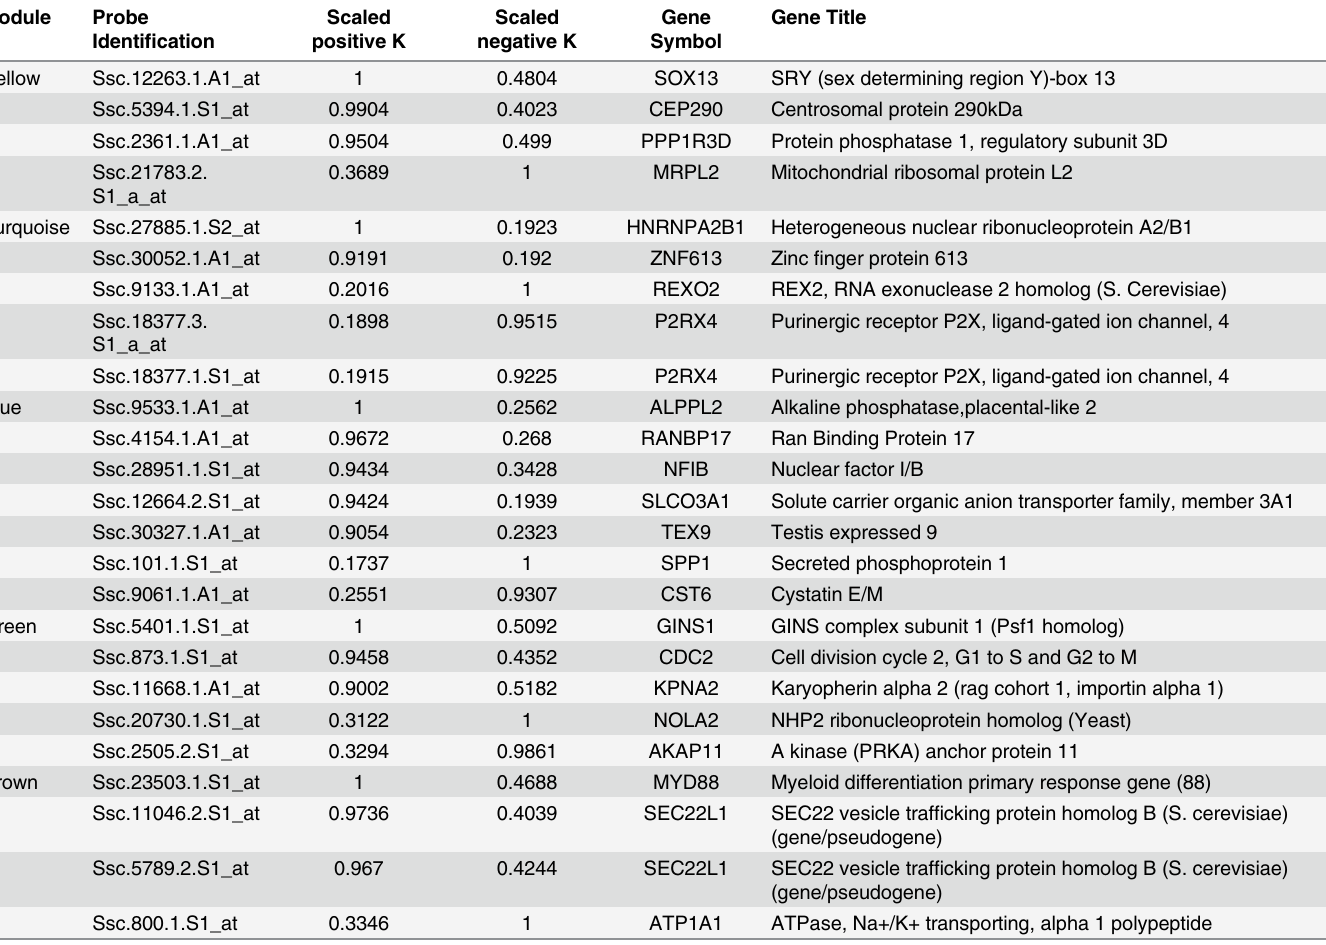
Fig 3. Network analysis of gene expression in the porcine uterine endometrium during pregnancy to identify distinct modules of weighted coexpressed genes. (A) Dendrograms produced by average linkage hierarchical clustering of 24,123 genes based on topology overlap. The red line indicates the height at which the tree was cut (0.94, red line) to define the module. Different modules were assigned colors as indicated in the horizontal bar beneath the dendrogram. (B) Heatmap images of all genes involved in 5 network modules. Columns represent probe identifications and putative annotations, and rows represent day of pregnancy. Red indicates high levels of expression and green indicates low levels of expression.